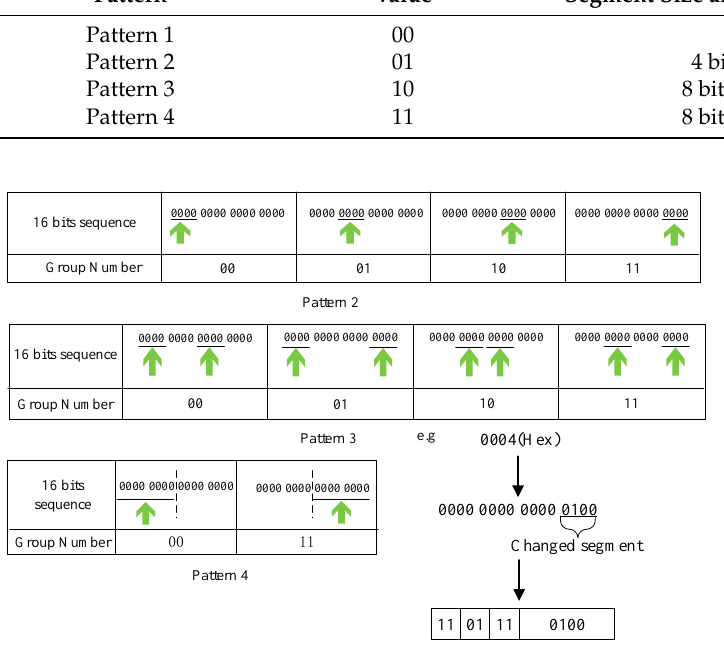
Figure 3. Pattern 2–4 diagram and compression example.